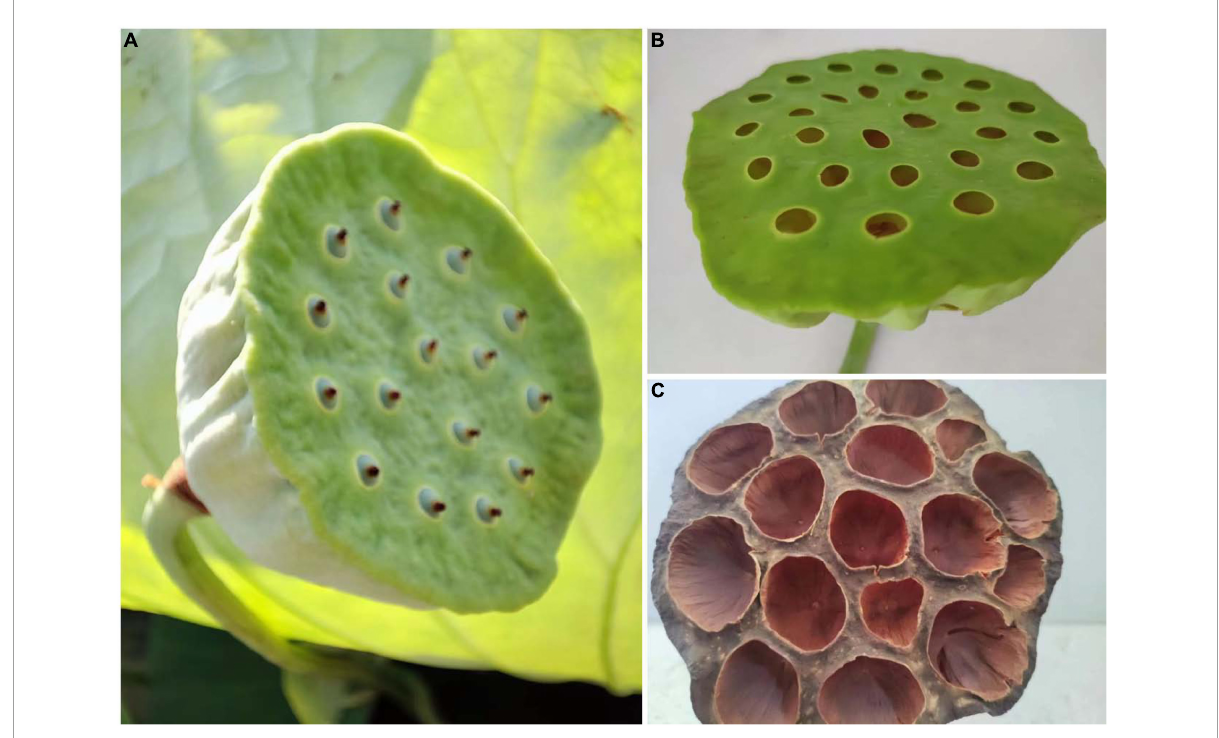
FIGURE1 Photographs of planted lotus (A) , fresh lotus seedpod (B) and sun-dried lotus seedpod (C) taken by Jian-Lin Shen in August,